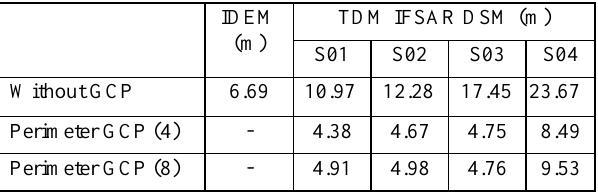
Table 5. ICP Level 2 (Final accuracy assessment)